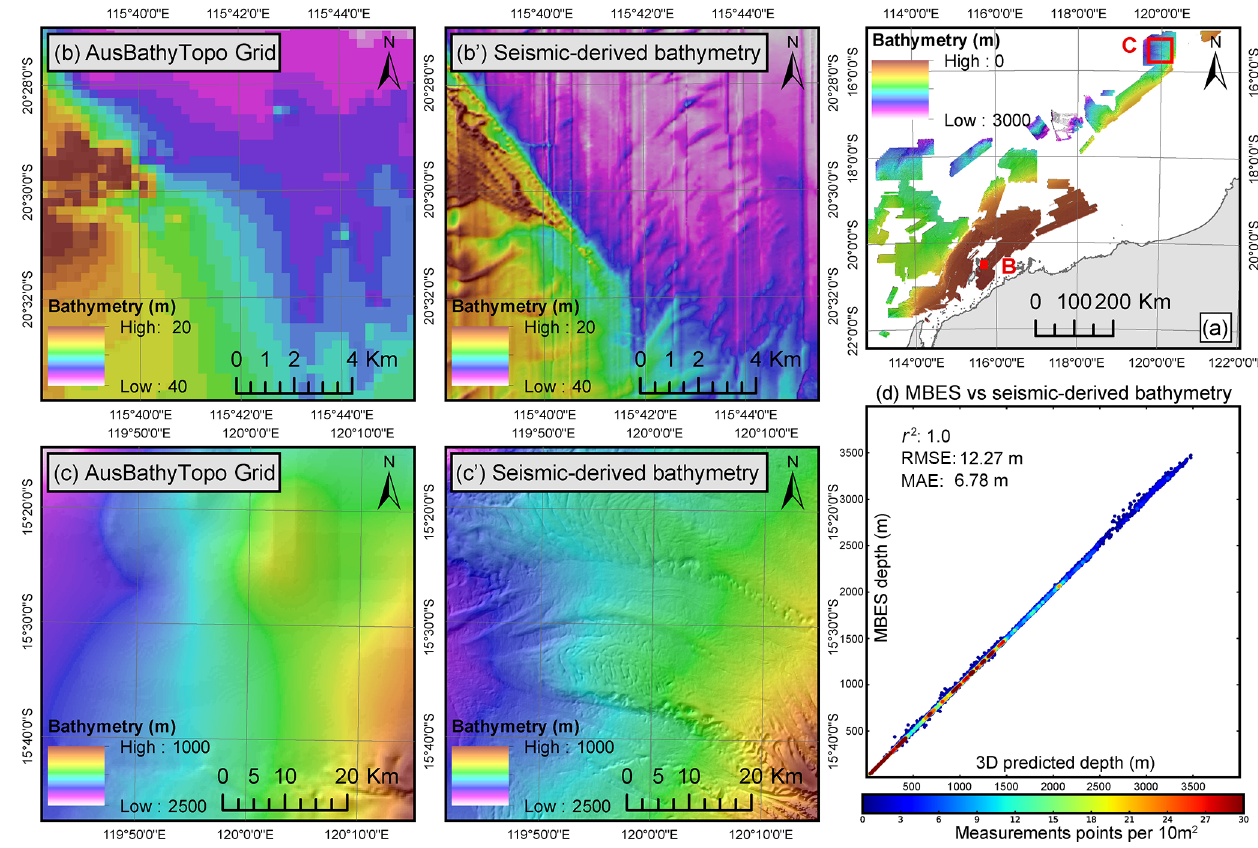
Figure 6. The seismic-derived bathymetry (a) is mainly composed of navigation-derived bathymetry (b’) in depth of less than 150m and of reflection-derived bathymetry (c’) in deeper waters. A total of 12676 data points were extracted along a mesh from both MBES and seismic-derived bathymetry to assess the accuracy of the dataset using the coefficient of correlation ( r 2 ), the mean average error (MAE) and the root mean square error (RMSE) (d) . The produced bathymetry marks a significant improvement compared to the Australian Bathymetry and Topography Grid from Whiteway (2009) ( b vs. b’ and c vs. c’ ). For data sources, see Sects. 3.1, 4.2.1, and 4.3.1. Table 1. Statistical metrics of the seismic-derived